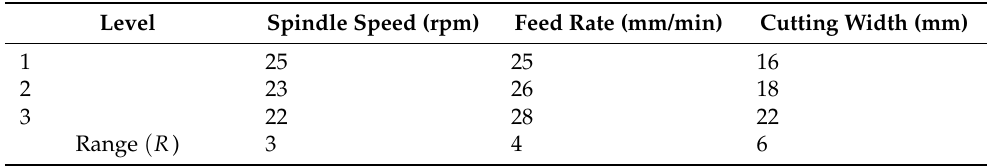
Figure 22. Surface morphology at different cutting parameters in orthogonal experiments. Table 7. Two-factors/four-levels and one-factor/three-levels orthogonal experimental significance analysis of total amount of tearing N